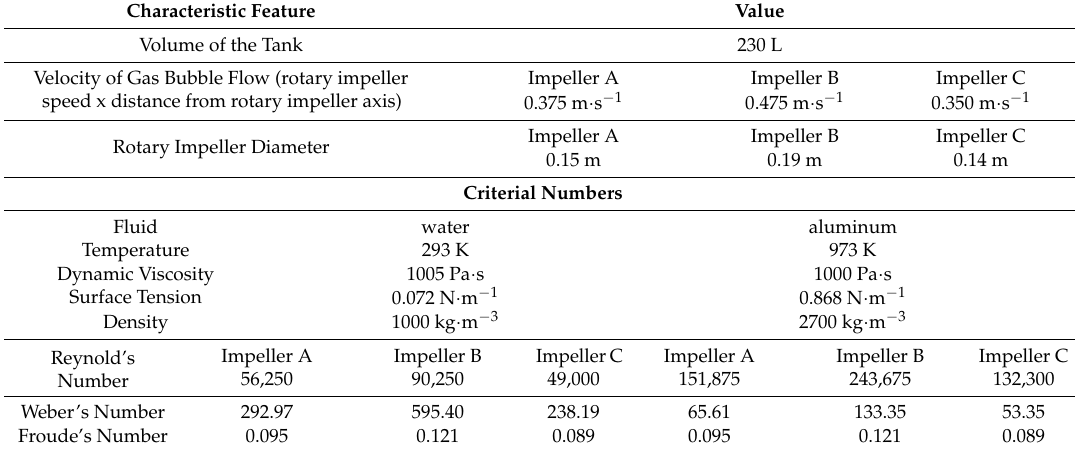
Table 1. Main characteristics and dimensions of URO-200 water model and comparison of criterial numbers for water and aluminum, calculated for URO-200 reactor for rotary impeller speed 5.00 s −1 .